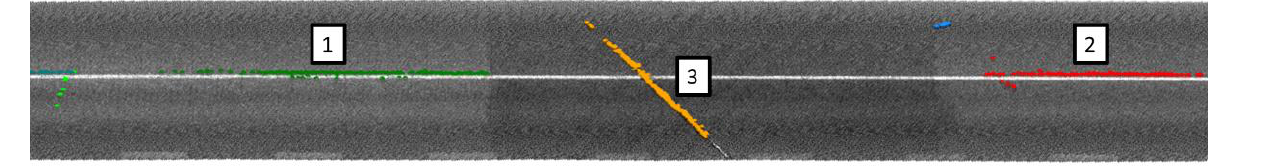
Figure 19. Road spot 4. Crack points detected with the proposed algorithm, grouped in clusters by color.